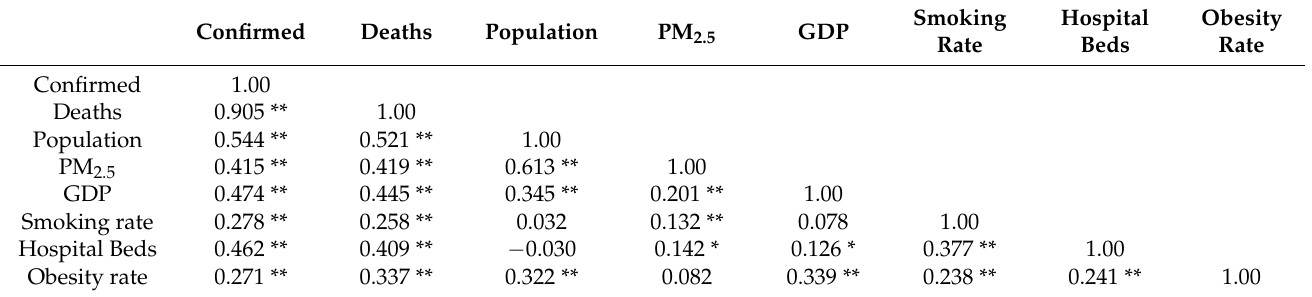
Table 2. Spearman correlation coefficients (r) between COVID and impact